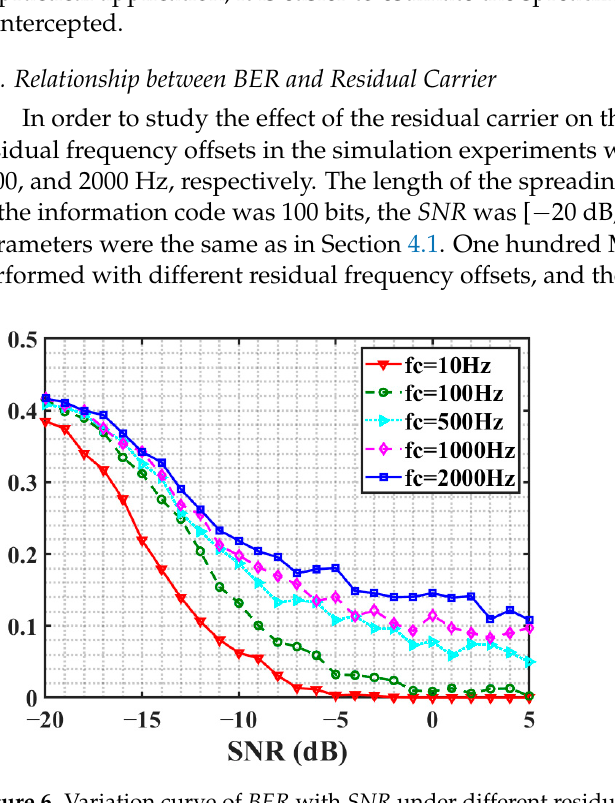
Figure 6. Variation curve of BER with SNR under different residual frequency offset conditions.